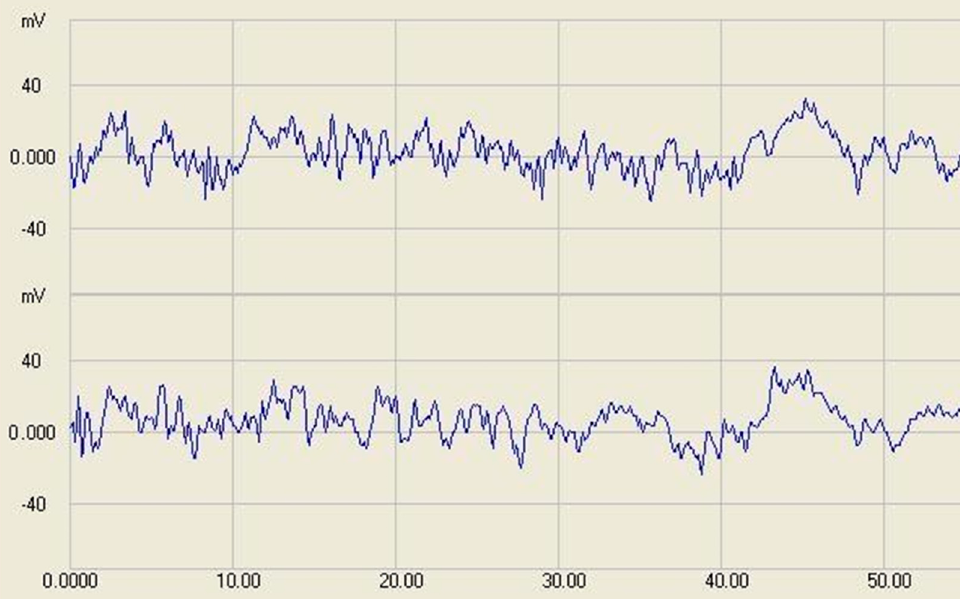
Figure 4. Baseline and standby noise signal of the sensor (no-detection state) at two sensors. The X-axis shows time in ms and Y-axis shows voltage in mV.